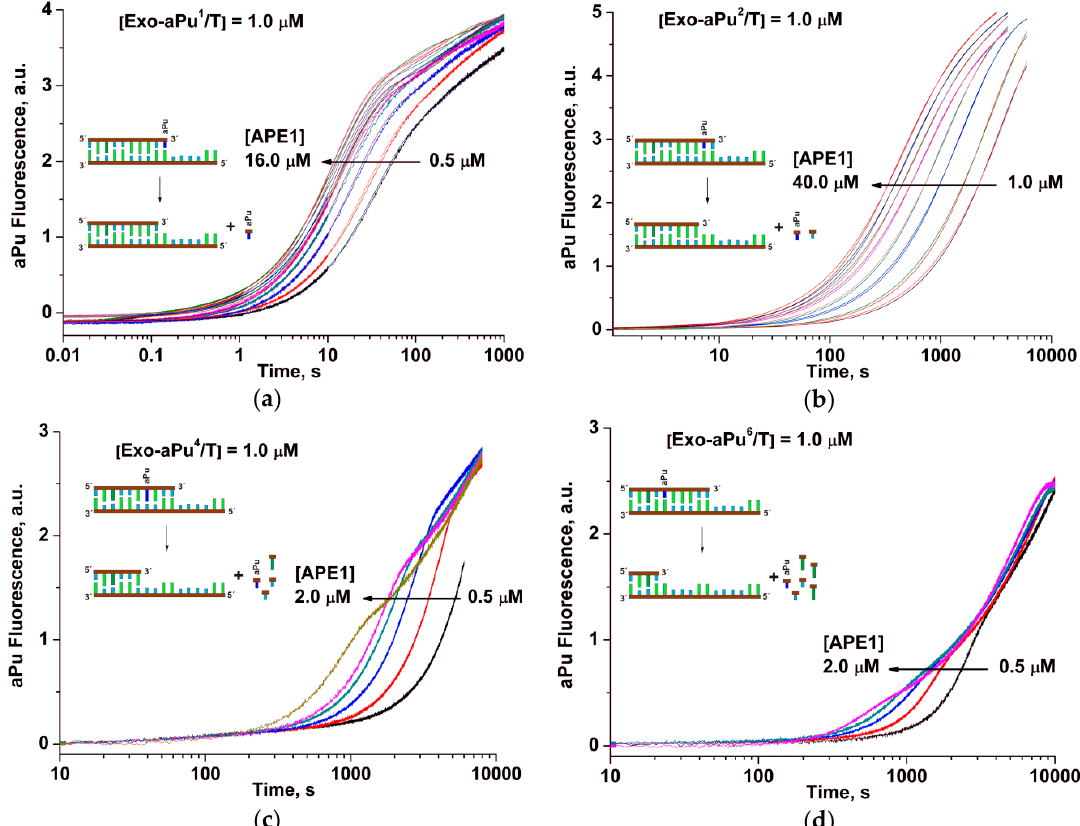
Figure 3. Changes in aPu fluorescence intensity during the interaction of APE1 with one of the substrates: ( a ) Exo-aPu 1 /T , ( b ) Exo-aPu 2 /T , ( c ) Exo-aPu 4 /T , or ( d ) Exo-aPu 6 /T . Concentrations of the enzyme and DNA are indicated in the panels. Kinetic traces for different APE1 concentrations are shown in different colors.